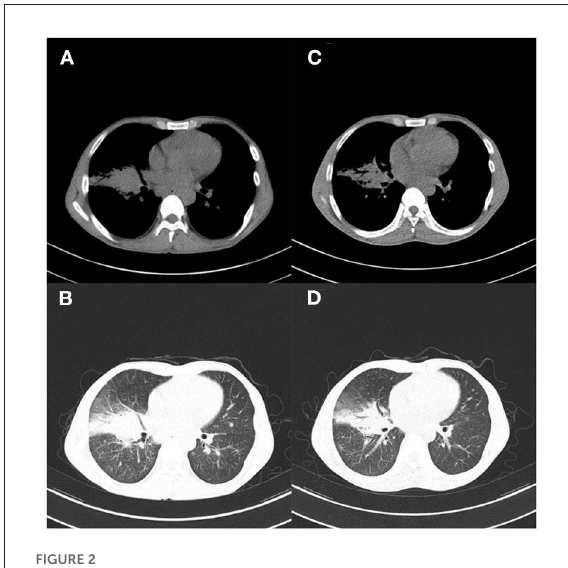
FIGURE4 Case 2. (A,B) Lung CT on the day of admission showed interstitial inflammation in both lungs and cavity formation in the upper lobe of the right lung, localized emphysema of both lungs, mediastinal lymph node enlargement, and bilateral localized pleural thickening; (C,D) 1 month later, CT examination showed that the double pneumonia was slightly more advanced than